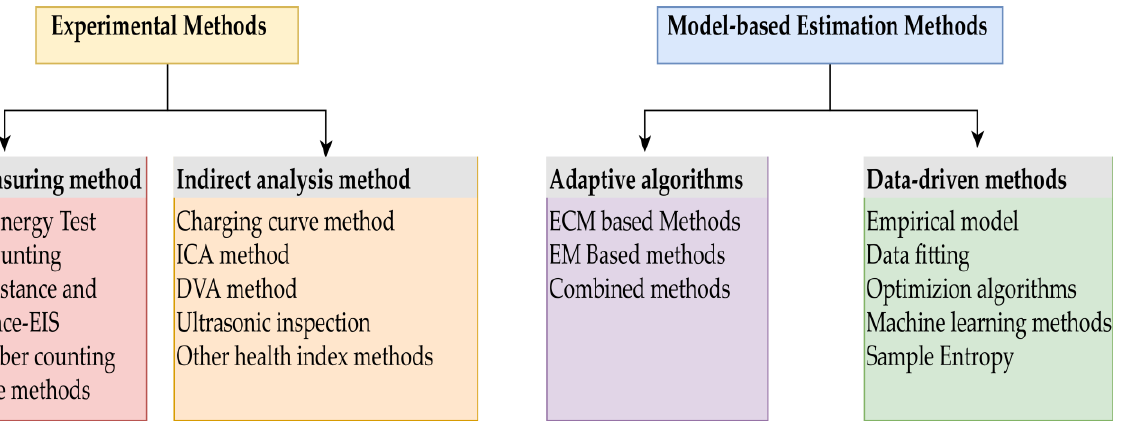
Figure 17. Different SOH estimation approaches.